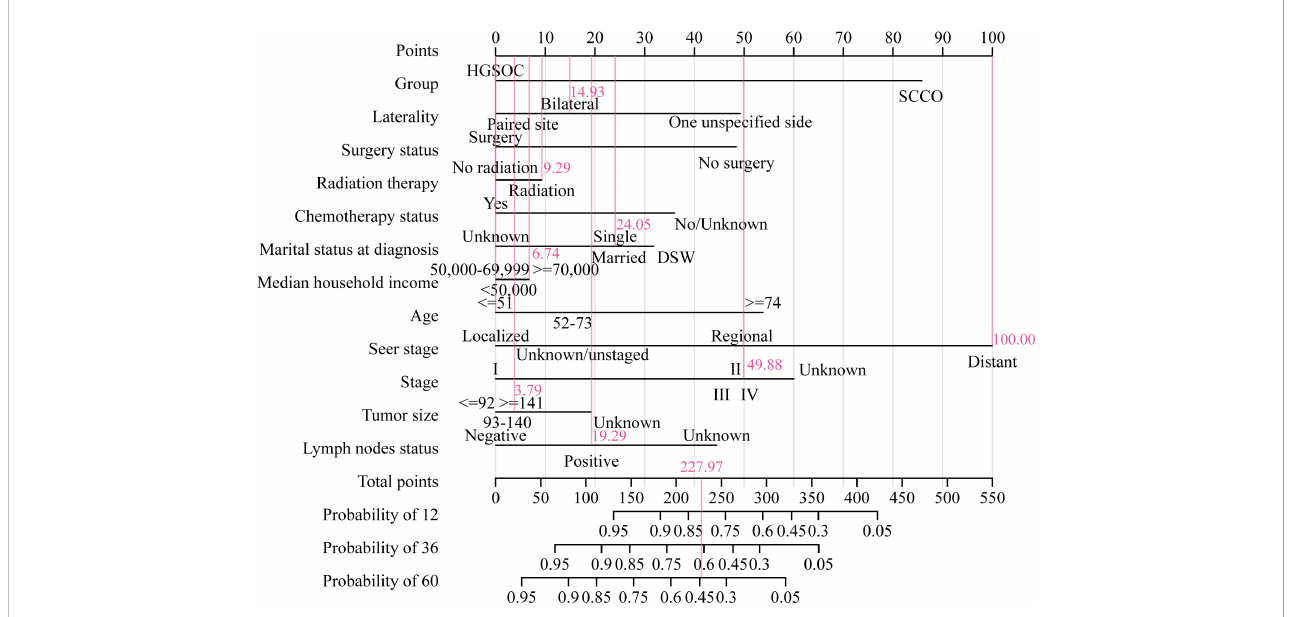
FIGURE 6 The nomogram of OS associated predictive models. The sum of the scores represented by the pink arrows represents the survival probability corresponding to 1, 3, and 5 years.